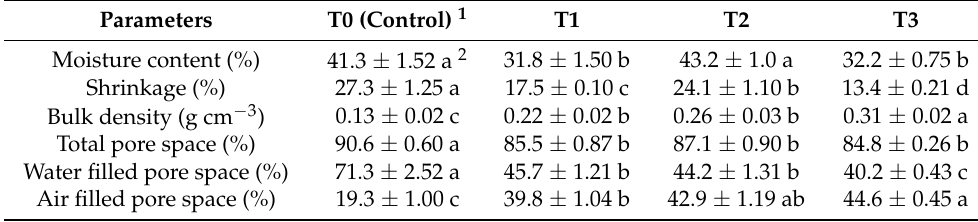
Table 5. Physical properties of tested growing media.